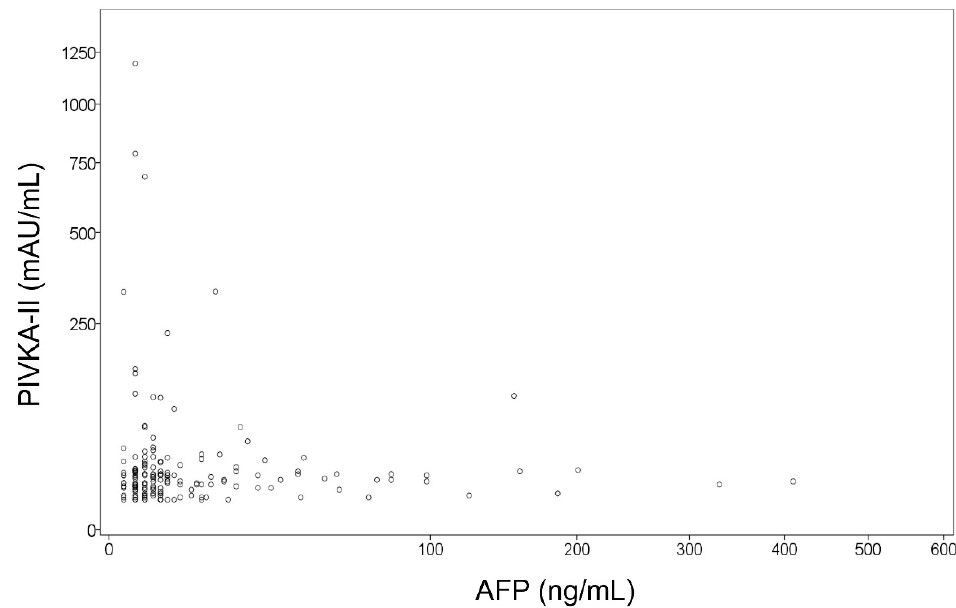
Figure 1. Scatter plot showing the association between α‐ fetoprotein (AFP) and protein induced by Vitamin K absence or antagonist ‐ II (PIVKA ‐ II) expression in patients with hepatocellular carcinoma of complete pathological response.